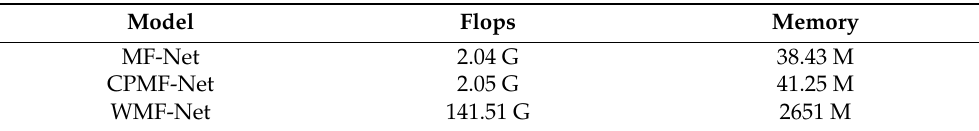
Table 3. Quantitative comparison of the computational resource occupation among different train- ing methods.